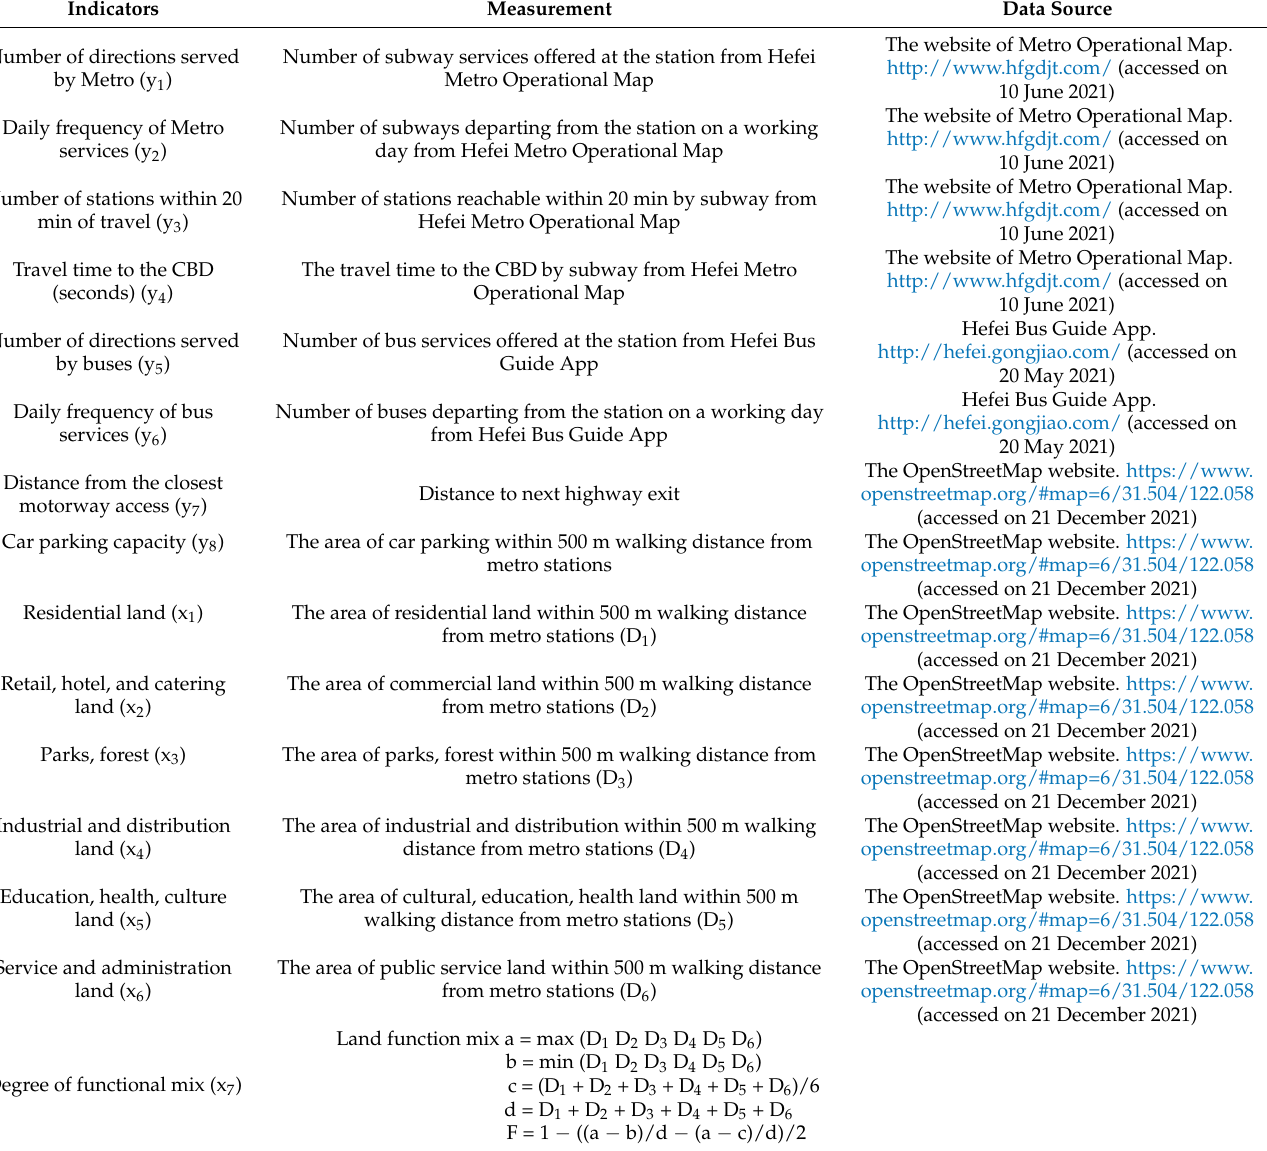
Table 2. The indicators chosen for the node- and place-values